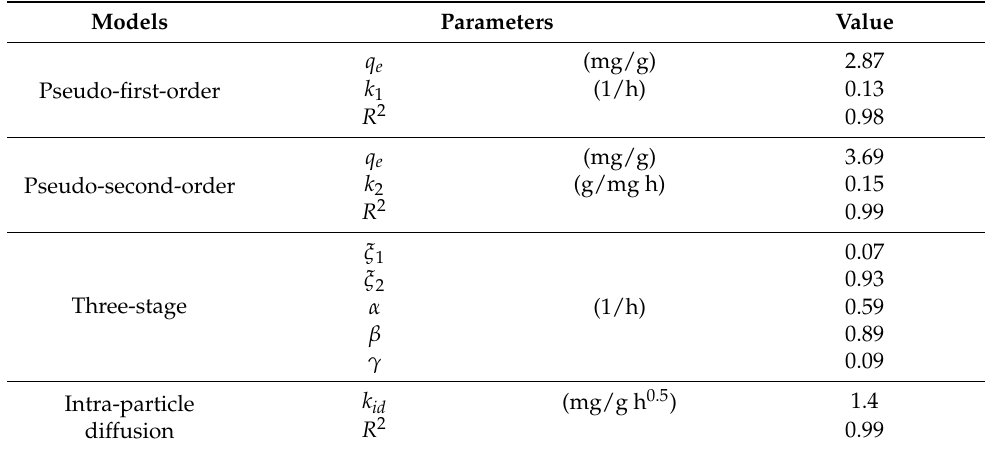
Figure 5. Adsorption kinetic data fitted to ( a ) pseudo-second-order and three-stage models and ( b ) an intra-particle diffusion model for Co(II) adsorption onto the b-HdA at 293 K. Table 5. Summary of the kinetic model parameters for Co(II) adsorption onto the b-HdA at 293